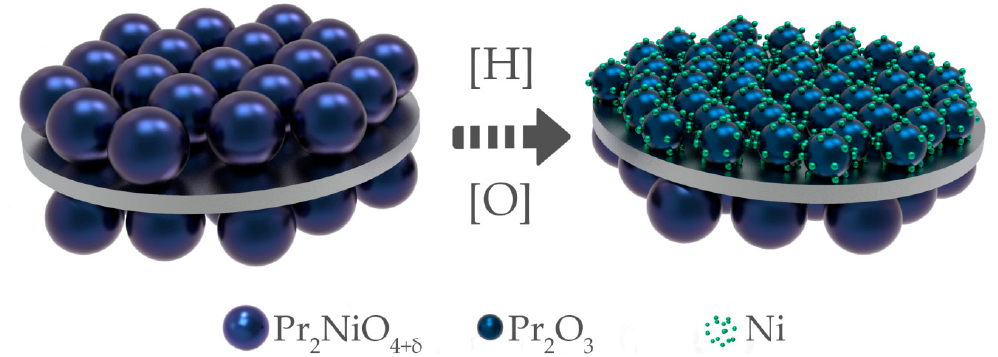
Figure 1. Principal scheme of a symmetrically designed PCC and Pr 2 NiO 4+ δ reduction with the formation of a Ni-based cermet.